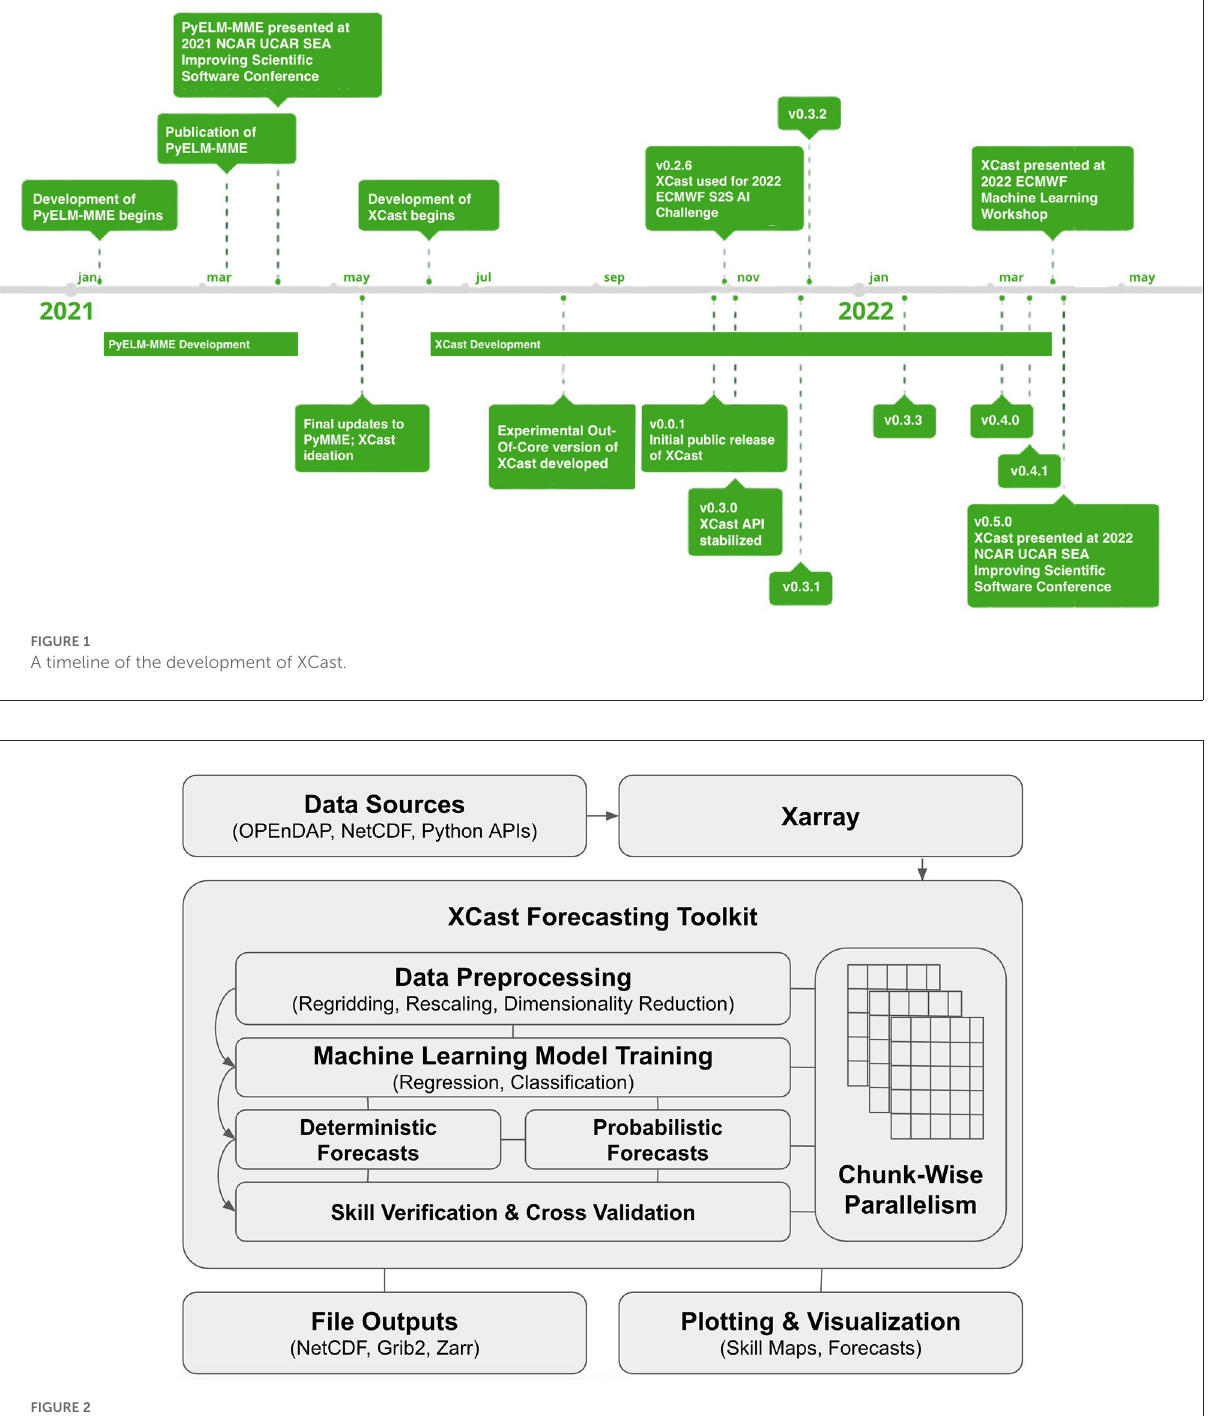
checking documentation and interrupting the development process. XCast’s Scikit-Learn-like interface also abstracts out all of the low-level high-performance computing